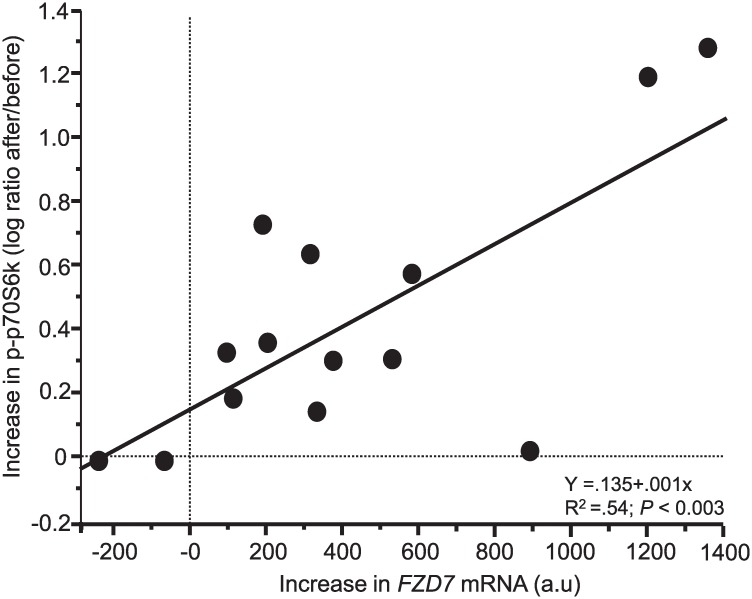
Sprint exercise–induced changes of gene expression related to changes in phosphorylation of p70S6k.Relationship between exercise-induced increase (2 h and 20 min post-exercise compared to rest) in p70S6kthr 389 and in mRNA of FZD7 in 7 men and 7 women. The increase in p70S6k is expressed as logarithm of the ratio after/before.